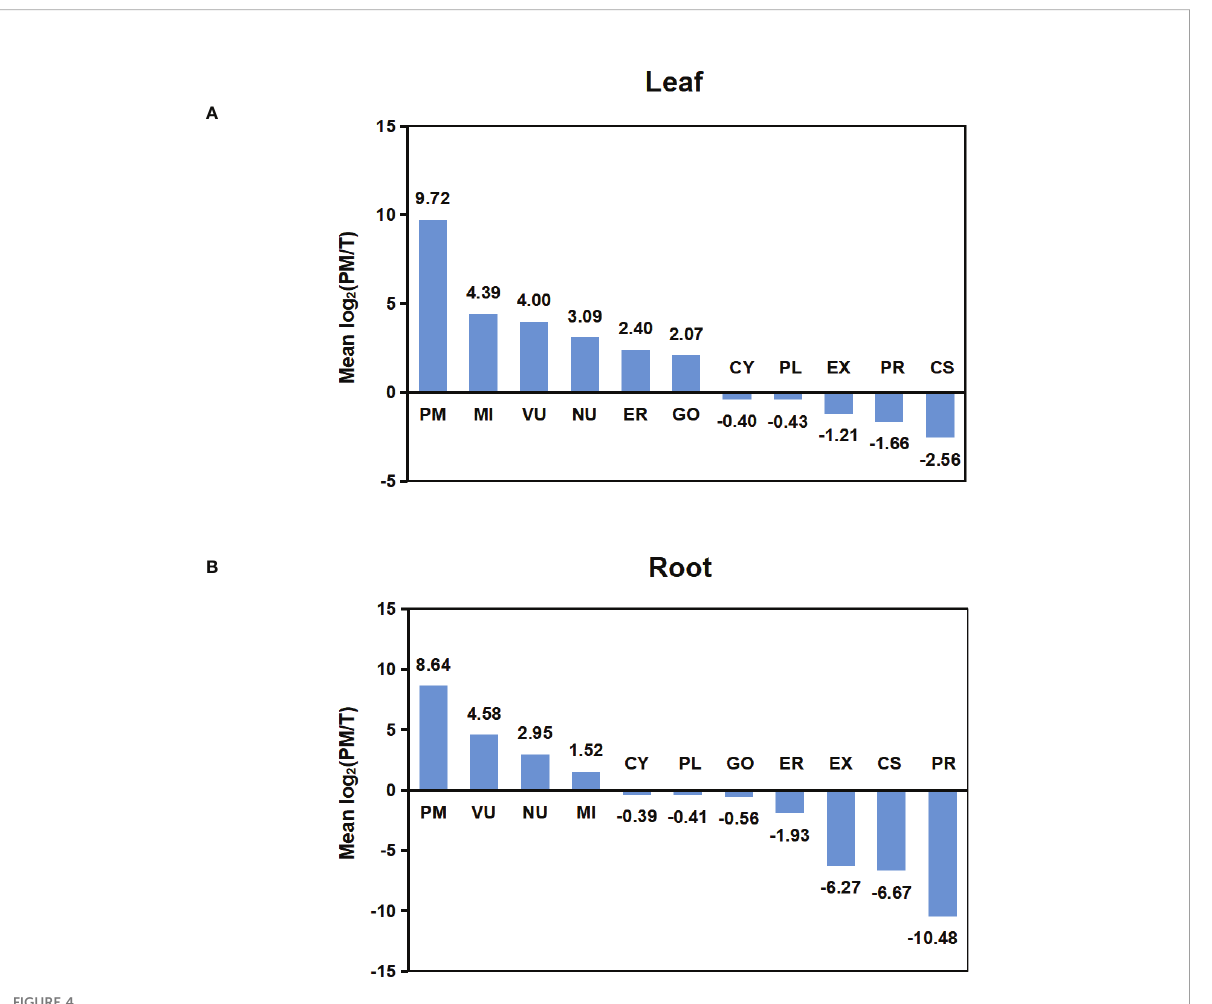
FIGURE 4 Abundance comparison of organelle proteomes between total and PM enriched fraction. (A) Abundance comparison of organelle proteomes between two fractions in leaf. (B) Abundance comparison of organelle proteomes between two fractions in root. Log2 values were calculated for the ratio of IBAQ value of proteins assigned to speci fi c compartments in PM or total fraction [i.e. log2(PM/T)]. The mean log2(PM/T) was calculated by using the average log2 values of all three biological replicas for each subcellular